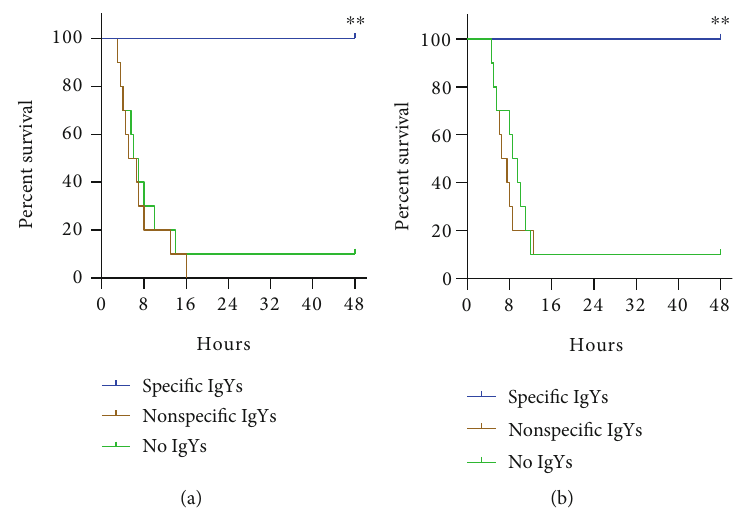
Figure 4: The survival protective e ff ects of anti- V. vulni fi cus IgYs in both the prophylaxis (a) and therapeutic (b) animal models (for each group, n = 10 ). ∗∗ p < 0 : 01